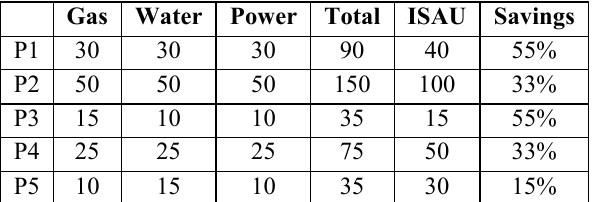
TABLE I. B ENEFITS OF THE ISAU AS COMPARED TO INDIVIDUAL SYSTEMS FOR VARIOUS